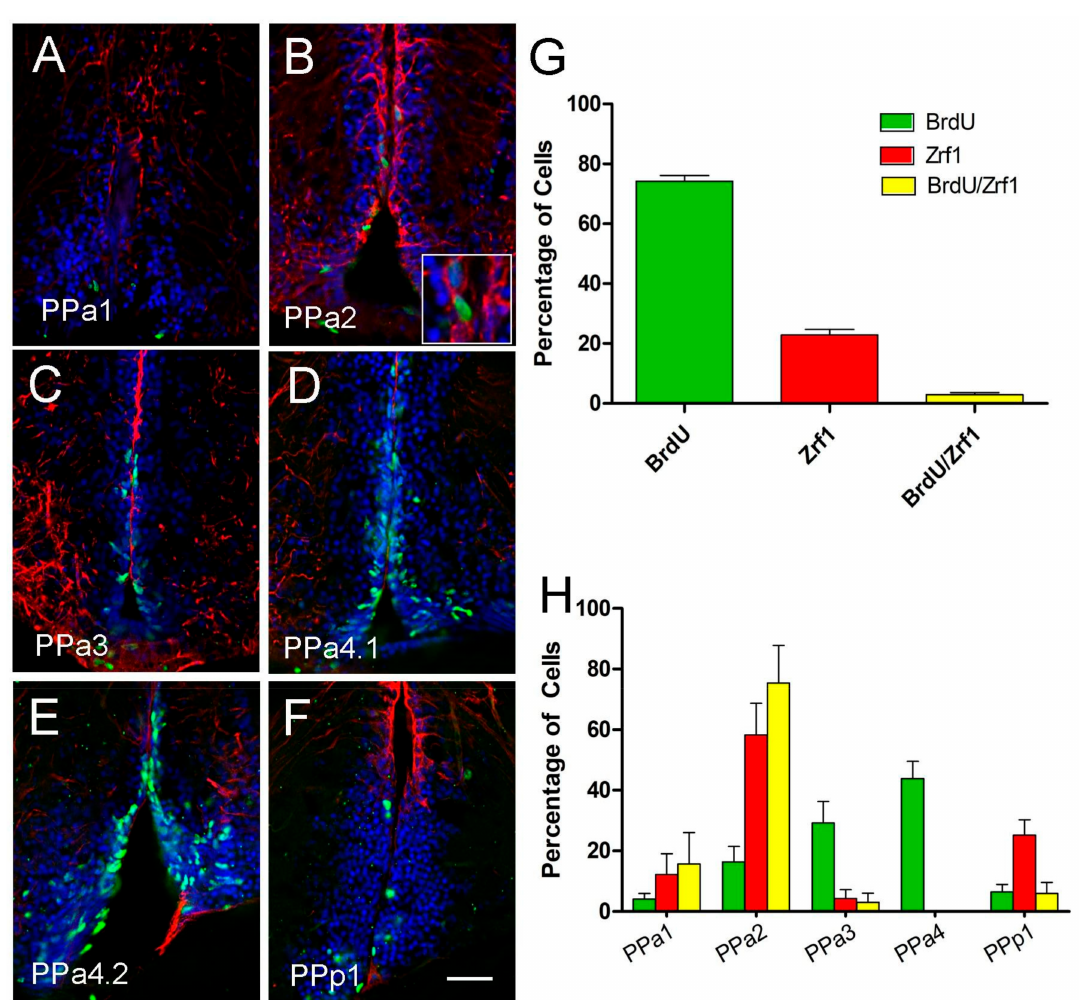
Figure 6. The majority of Zrf1 positive cells are non-proliferative and do not incorporate BrdU. ( A – F ) anti-BrdU/anti-Zrf1 double immunofluorescence in transverse cryosection of 20 µ m of the POA. Treatment with two pulses of BrdU at 1 and 7 days, and the brains were fixed at 8 days. Zrf1+ tanycytes (red), generally do not express BrdU (green), but a low number of Zrf1+ cells are BrdU+ (( B ), magnified image of boxed). All sections were labeled with DAPI (blue). Scale bar: 30 µ m. ( G ) Percentage of BrdU+, Zrf1+, and Zrf1+/BrdU+ cells distributed in the wall of the DiV of the POA. The cell count was obtained of the total immune-labeling cells of the POA. ( H ) Percentage of BrdU+, Zrf1+, and BrdU+/Zrf1+ cells are located in representative sections of the POA (PPa1 = 2, PPa2 = 2, PPa3 = 2, PPa4 = 3 and PPp1 = 2) where BrdU+, Zrf1+, and Zrf1+/BrdU+ cells were